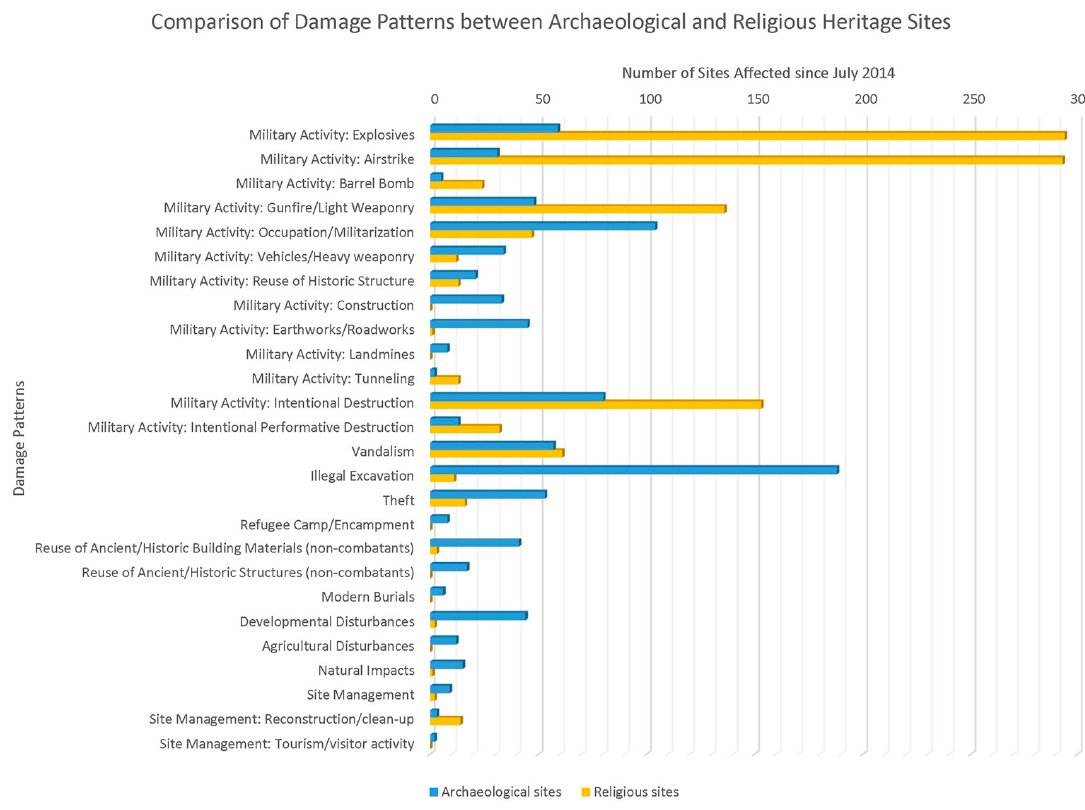
Figure 3. Comparison of the causes of damage to archaeological and religious heritage sites in Syria and Northern Iraq between 1 July 2014 and 30 June 2017 (ASOR CHI; 26 July 2017).